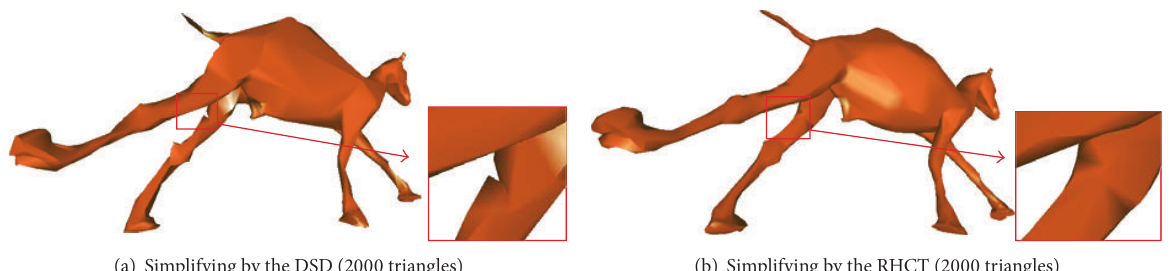
Figure 11: The thigh shape of camel is destroyed after simplifying by the DSD.